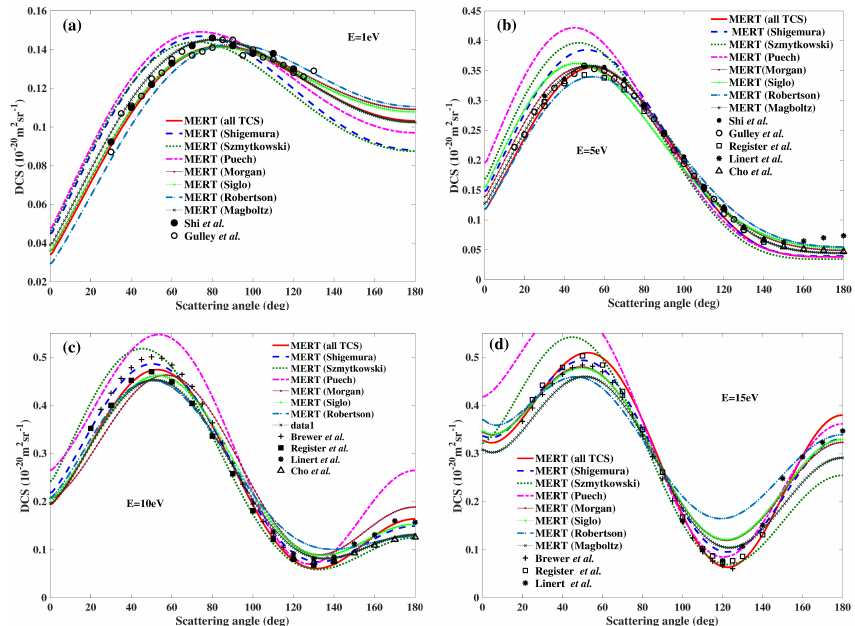
Figure 4. Angular dependencies of MERT − derived differential cross − sections at ( a ) 1, ( b ) 5, ( c ) 10, and ( d ) 15 eV for e − − Ne scattering. The present results are compared with experimental data of Shi and Burrow [48], Linert et al. [49], Cho et al. [50], Register and Trajmar [43], Gulley et al. [51], and Szmytkowski et al.